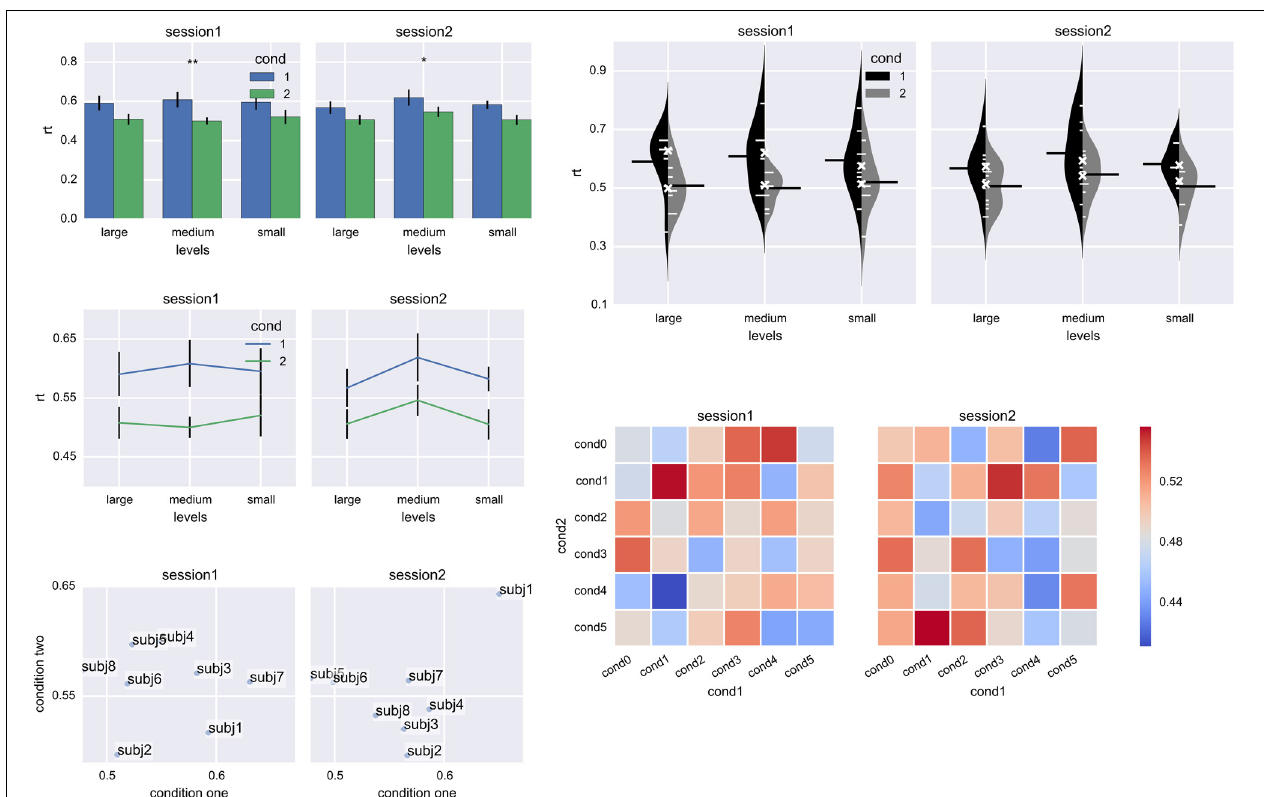
FIGURE 6 | Plots generated by the plot module. Left panel: bar plot, line plot, and scatter plot; right panel : bean plot (Kampstra, 2008) and matrix plot. The pretty color scheme is applied by default